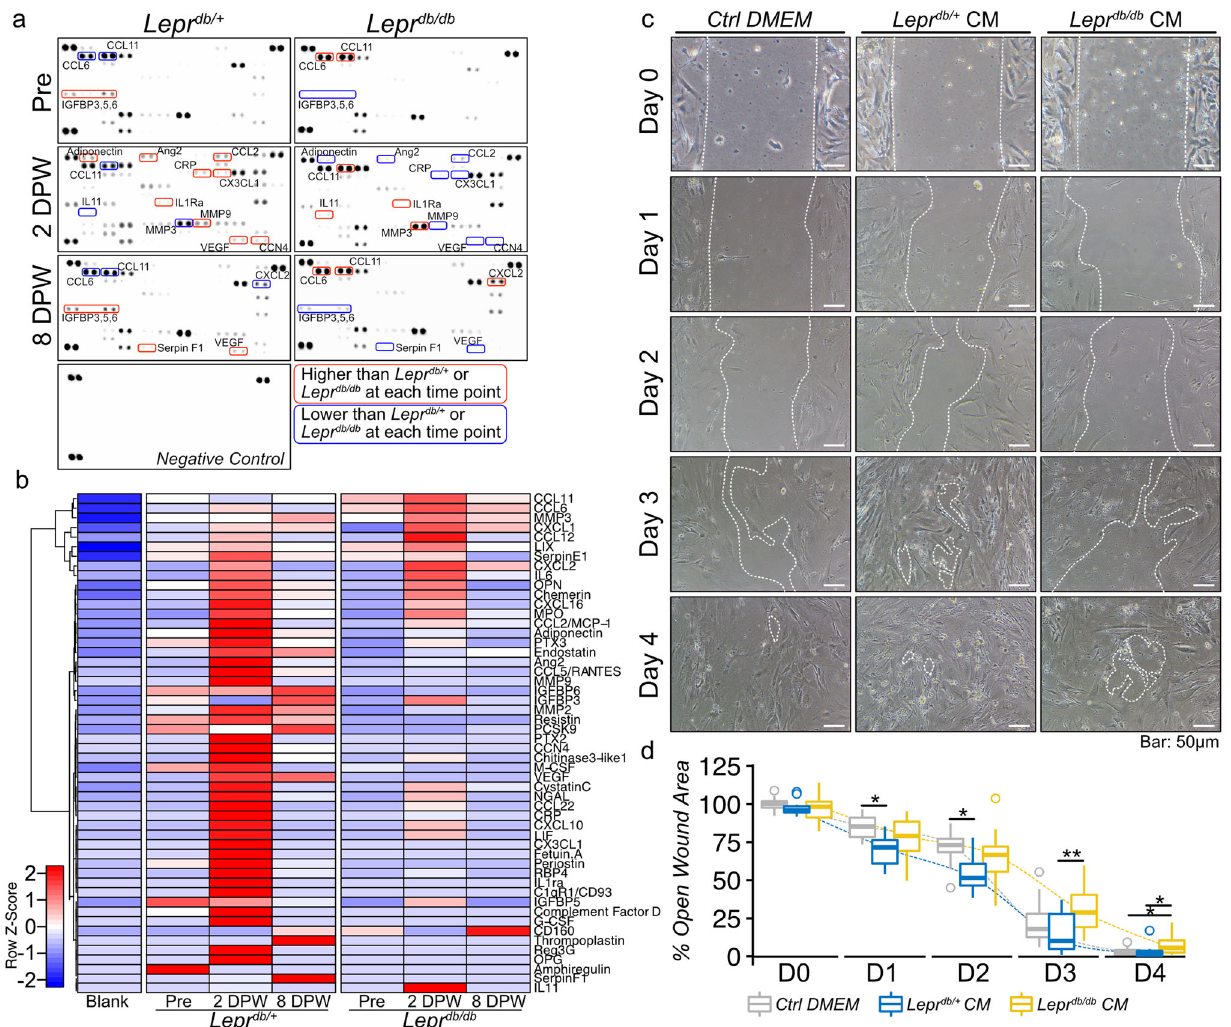
Fig. 6 Components of post-wound adipose tissue-derived cytokines in Lepr db/ + and Lepr dbdb + mice and their effect on cell migration. a Proteome pro fi ler antibody array analysis of SASP-containing culture media (CM) collected from the organ culture of adipose tissue at pre-wounding, 2 DPW, and 8 DPW. b Hierarchical clustering of differentially expressed cytokine expression. Cytokines with higher expression are depicted in red, cytokines with lower expression are depicted in blue, and cytokines with no difference are depicted in white. c Representative phase-contrast image of wound assay treated with adipose tissue-derived cultured media collected from either Lepr db/ + or Lepr db/db mice at 2DPW and ( d ) the percentage of wound closure at each time point, from immediately after wounding (D0) to 4 d after wounding (D4) (Ctrl DMEM: n = 15; Lepr db/ + CM: n = 12; Lepr db/ + CM: n = 15). Quantitative data are shown as box-and-whisker plots with IQRs and 1.5 times the IQR. p -values were determined using the Tukey method for one-way ANOVA (* p < 0.05 and ** p <